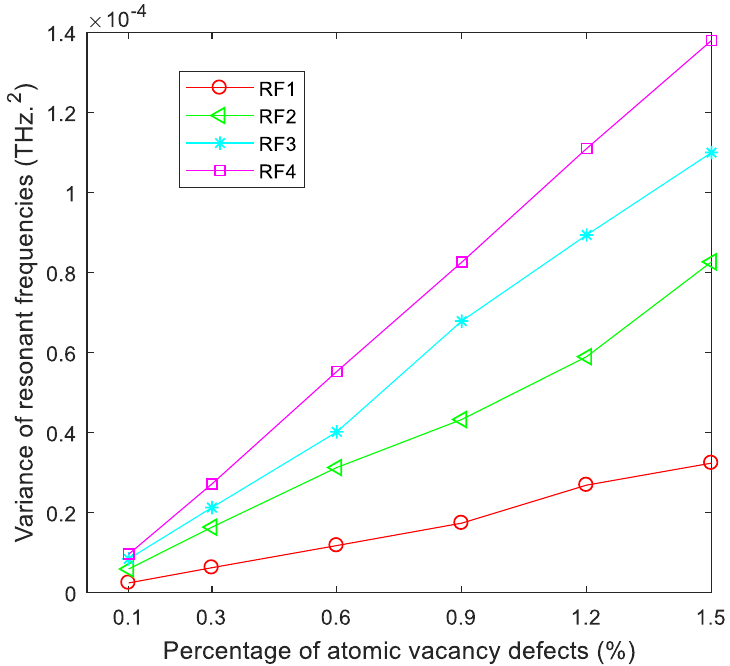
Figure 2. Variance of resonant frequencies for porous graphene (RF1-RF4 are the variances of resonant frequencies in the first- to fourth-order vibration modes, respectively).